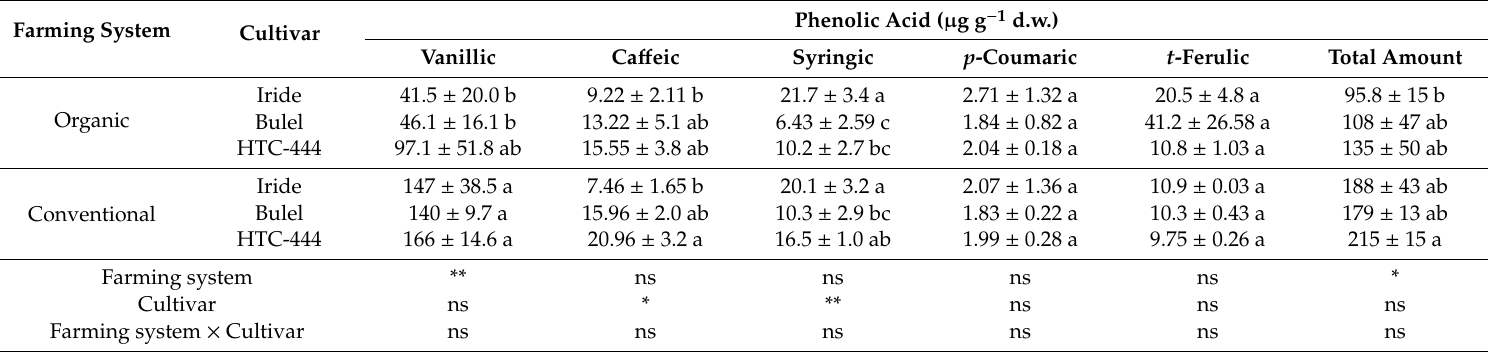
Table 4. Total soluble phenol contents and phenolic acid profiles (mean ± SE; n = 9) in grains of durum wheat (cv. Iride) and Tritordeum (cv. HT-444 and Bulel) cultivated under organic and conventional agricultural systems. Letters indicate statistically significant di ff erences among cultivars within the same farming system (Newman–Keuls test, p ≤